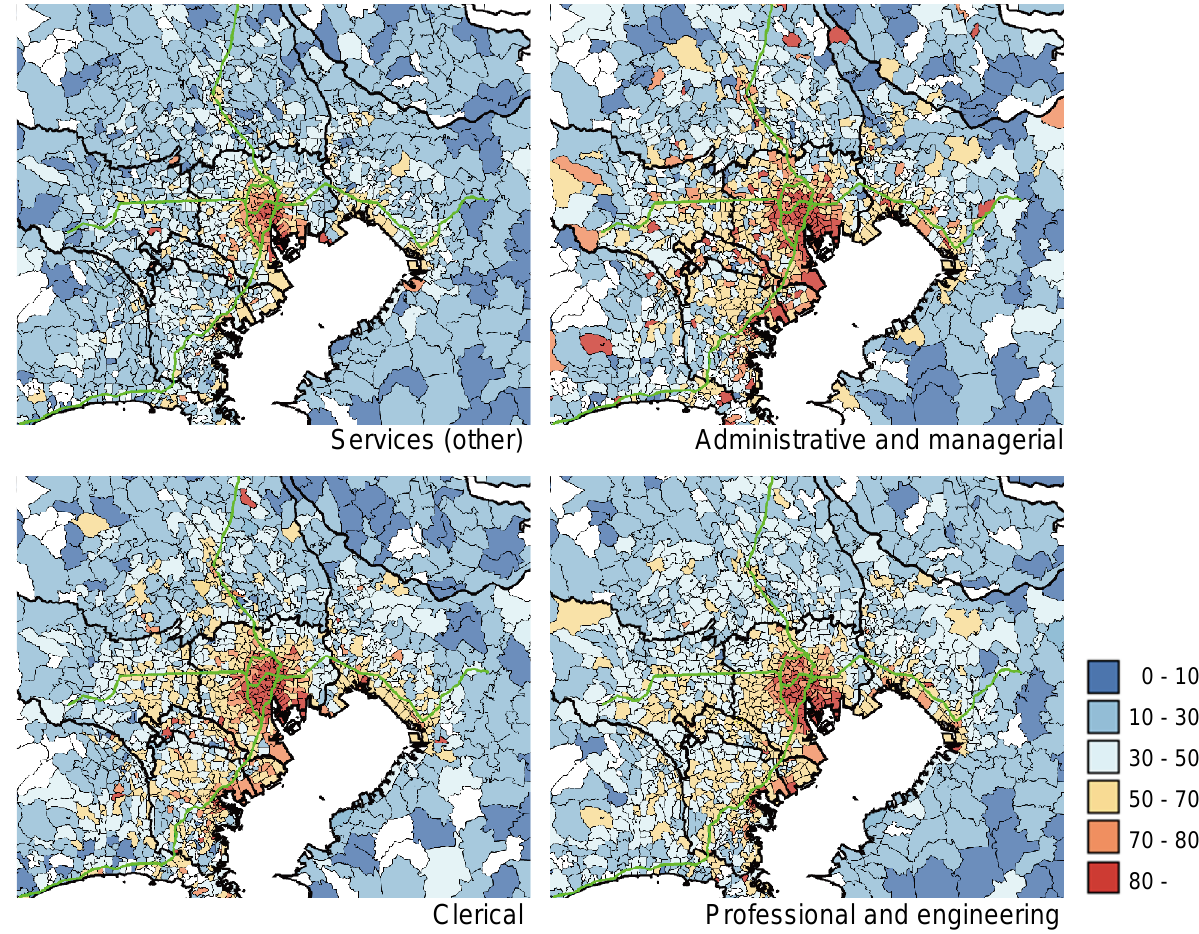
Figure 16. Spatial distribution of percentages of commuting difficulty yielded by four occupational categories on an employment-zone basis under travel-mode Condition